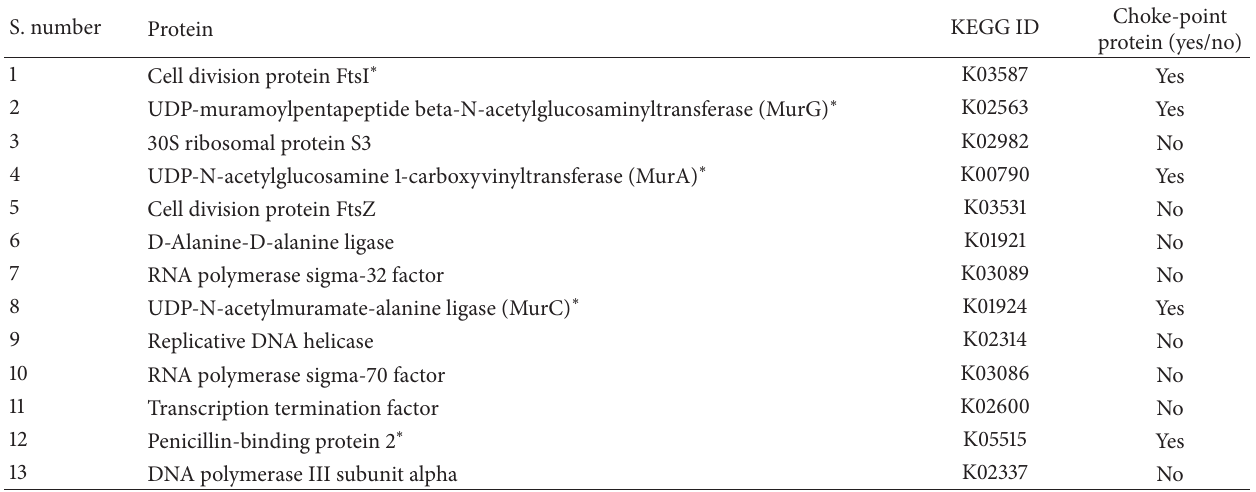
Table 3: List of 13 proteins in Dichelobacter nodosus that were common in at least 10 pathogenic bacterial species. The results for the choke- point analysis for each protein are also